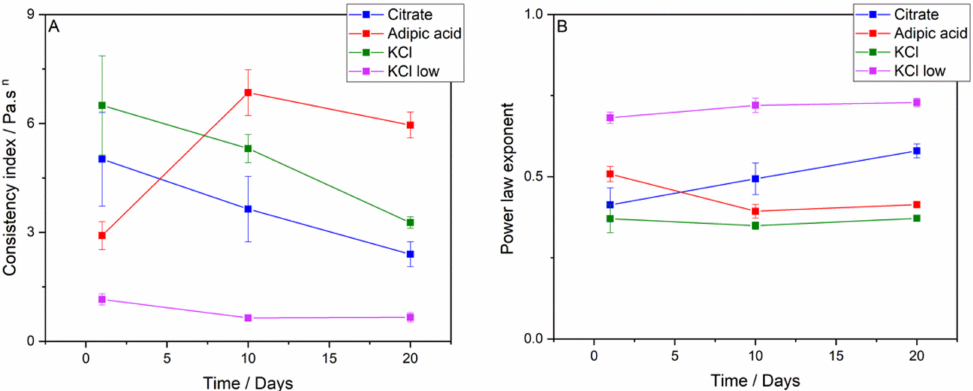
Figure 6. The change in power law parameters consistency index, k (Panel ( A )), power law exponent, and n (Panel ( B )) as a function of